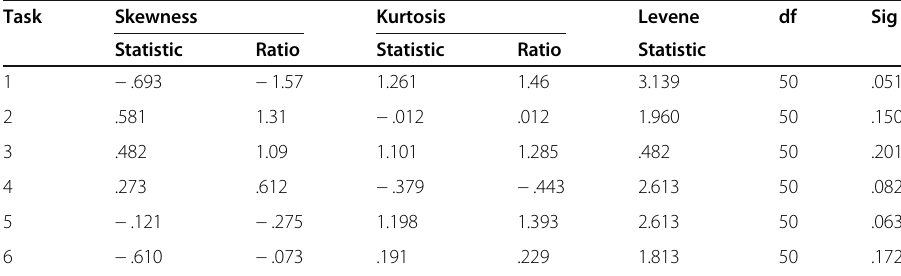
Table 3 Testing the normality assumption in feedback points on descriptive writing tasks